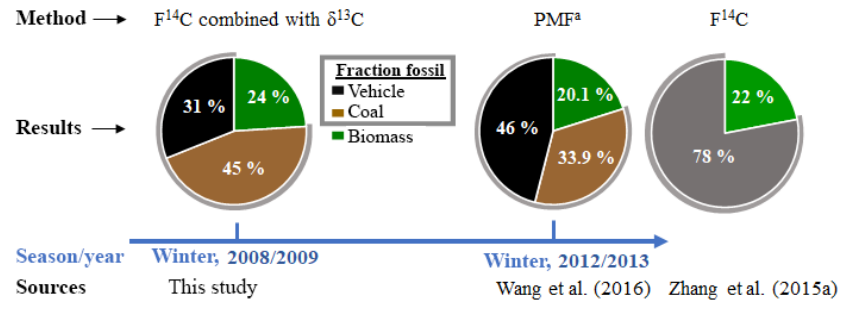
Figure 8. Comparison of EC source apportionment in winter 2008/2009 with two other studies in winter 2012/2013 at the same sampling site. a Positive matrix factorization (PMF) receptor model